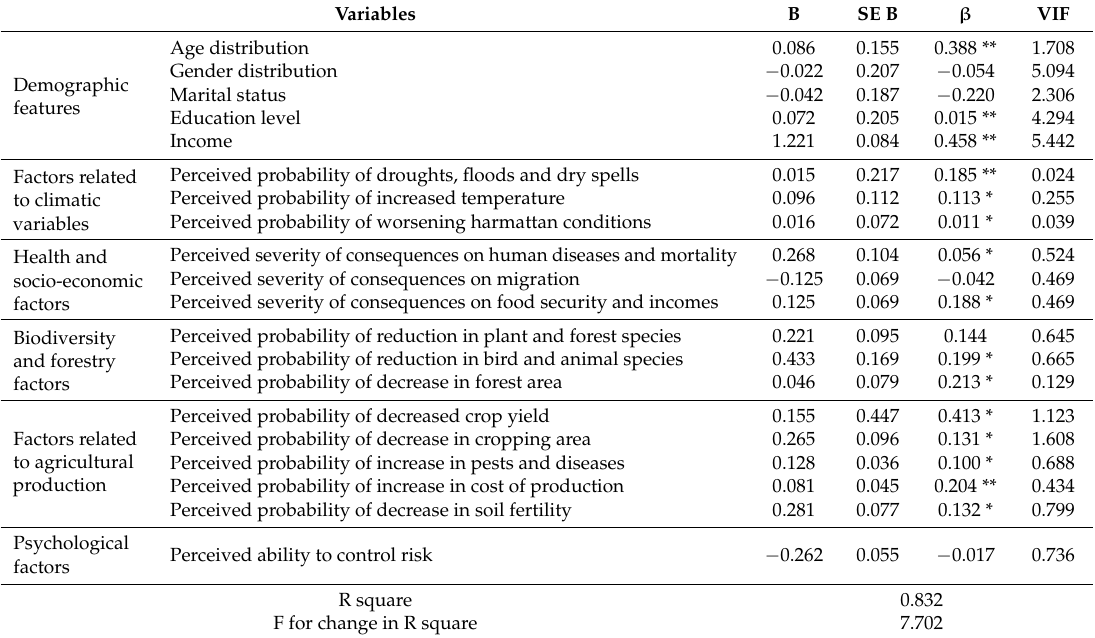
Table 8. Estimated results of determinants of climate risk perception of farmers in Lawra district ( N =